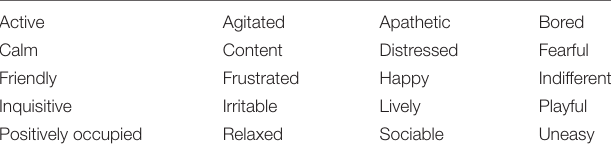
TABLE 1 | Terms for the visual analogue scale of the QBA. Active Agitated Apathetic Bored Calm Content Distressed Fearful Friendly Frustrated Happy Indifferent Inquisitive Irritable Lively Playful Positively occupied Relaxed